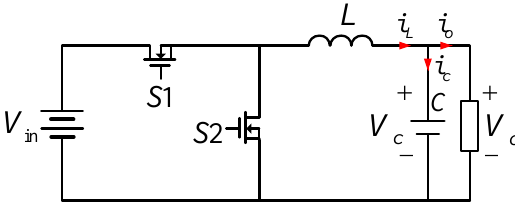
Figure 9. Synchronous buck converter.